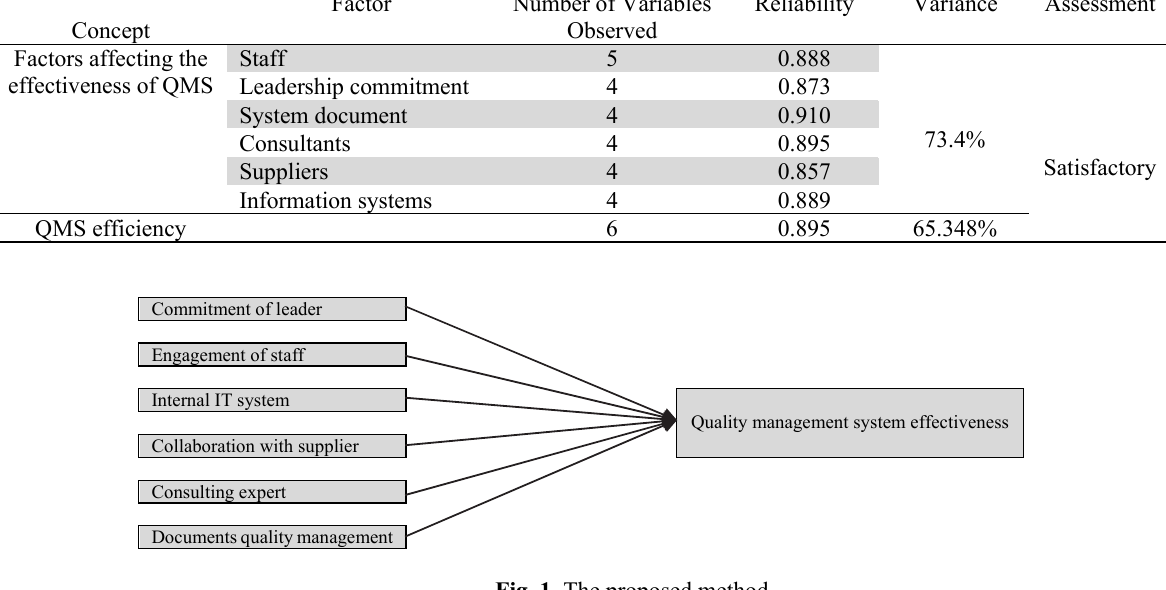
Fig. 1. The proposed